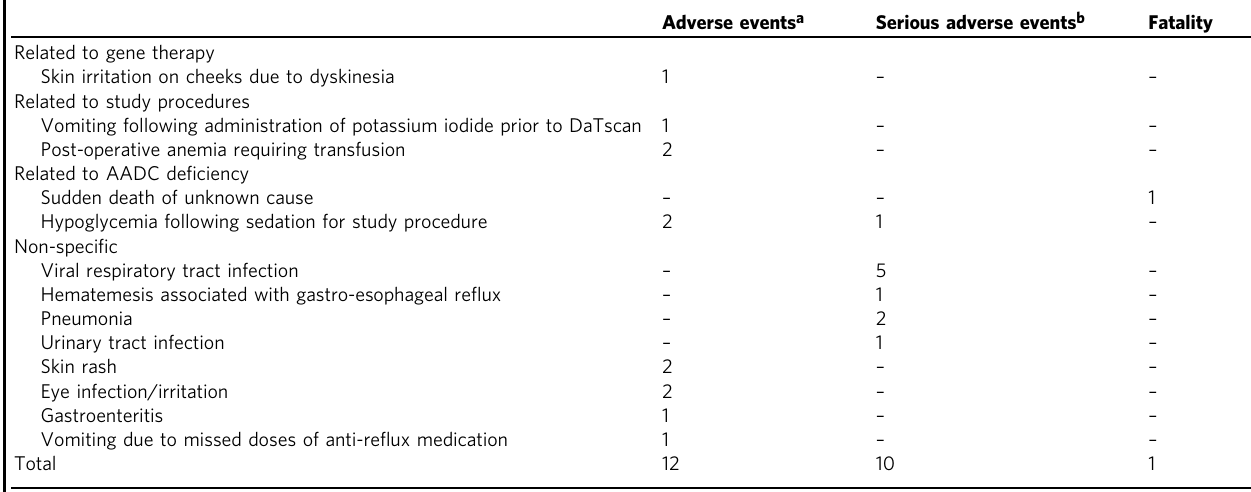
Table 4 Summary of adverse events and serious adverse events.